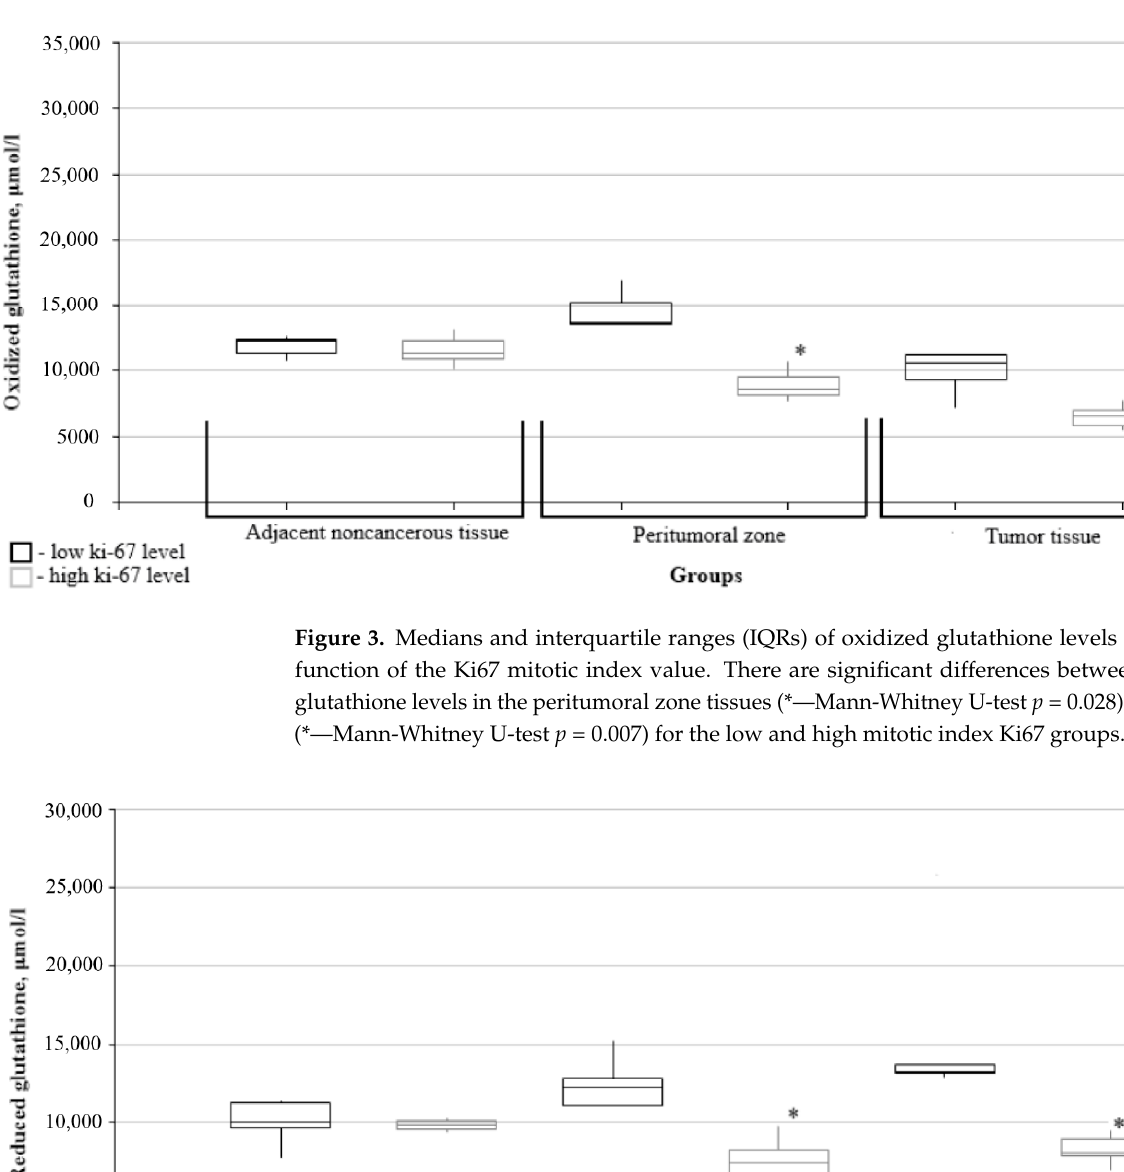
Figure 5. Medians and interquartile ranges (IQRs) of glutathione peroxidase levels in gliomas as a function of the Ki-67 mitotic index value. There are significant differences between the glutathione peroxidase levels in peritumoral zone tissues (* ̵ Mann-Whitney U-test p = 0.004) and the low and high mitotic index Ki-67 groups. The glutathione transferase level in the peritumoral zone was significantly lower in the group of patients with gliomas having a high Ki-67 mitotic index (Figure 6).